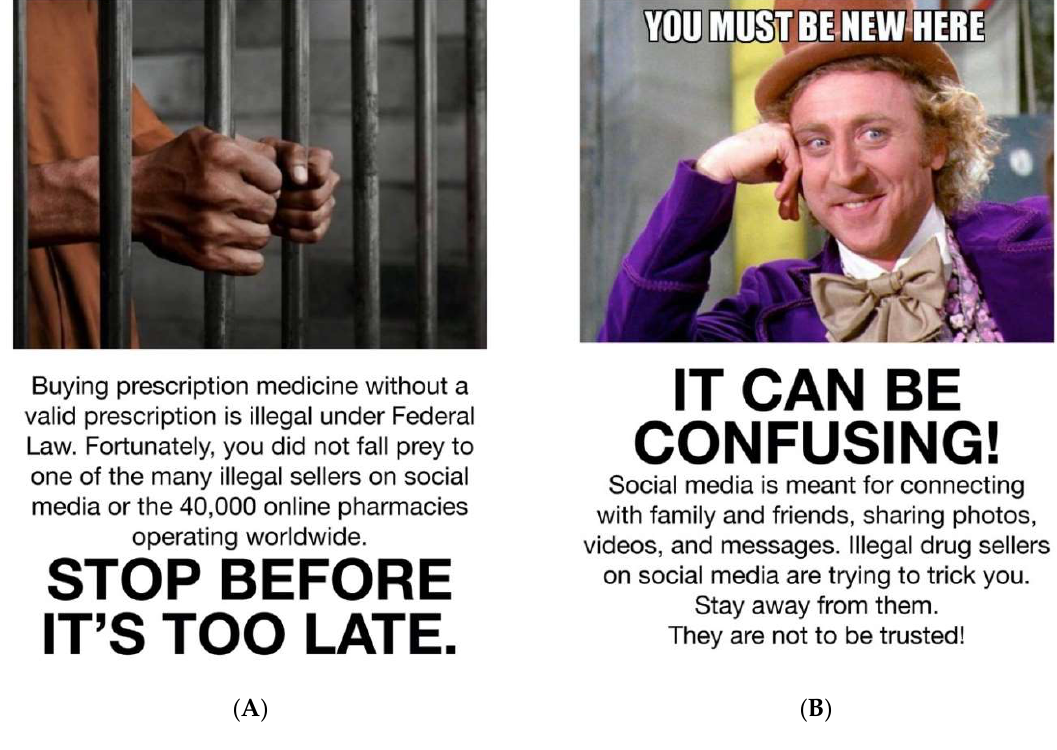
Figure A1. ( A ) Fear Appeal PSA. ( B ) Humor Appeal PSA.